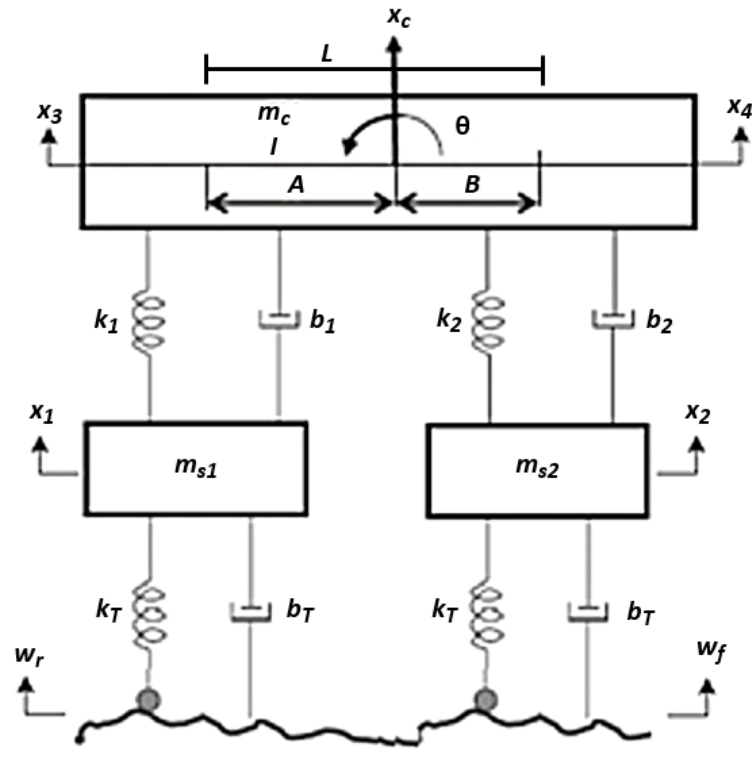
Figure 5. Half-car passive suspension